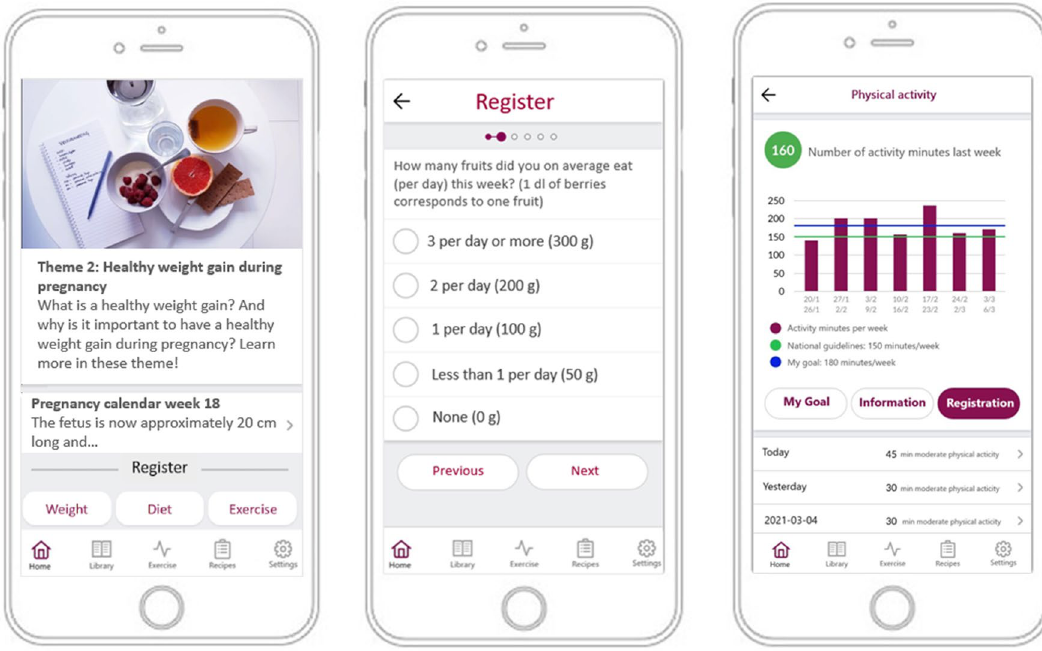
Figure 1. Screenshots of the HealthyMoms app (translated from Swedish to English). Left panel: Homepage of the HealthyMoms app with access to the registrations of the self-monitoring features for weight-, diet- and physical activity; Middle panel: Example of the diet registration feature; Right panel: Example of feedback for physical activity